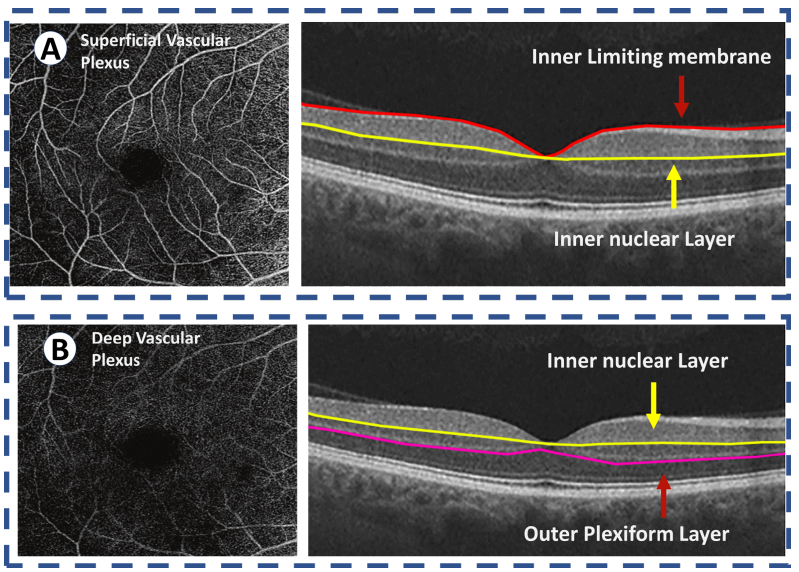
Figure 6. OCT angiography of the normal retina images the two vascular plexuses. ( A ) The superficial vascular plexus supplies the inner retina, defined as between the internal limiting membrane and the inner border of the inner nuclear layer. ( B ) The deep vascular plexus supplies the middle retina, defined as between the inner border nuclear layer and the outer border of the outer plexiform layer. The outer retina is avascular and receives its blood supply from the